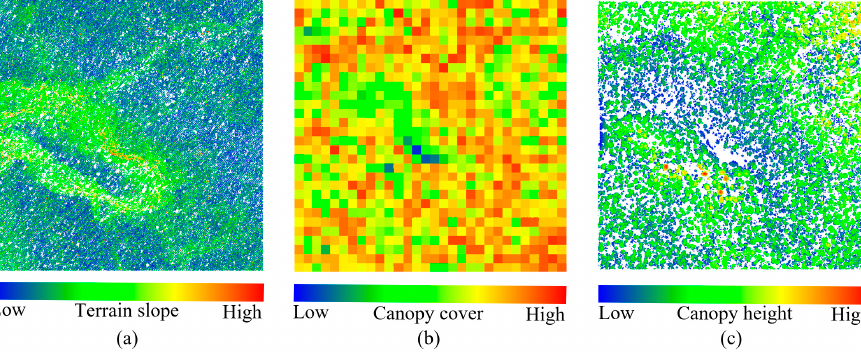
Figure 4. ( a ) Terrain slope, ( b ) canopy cover, and ( c ) canopy height maps for a sample site.